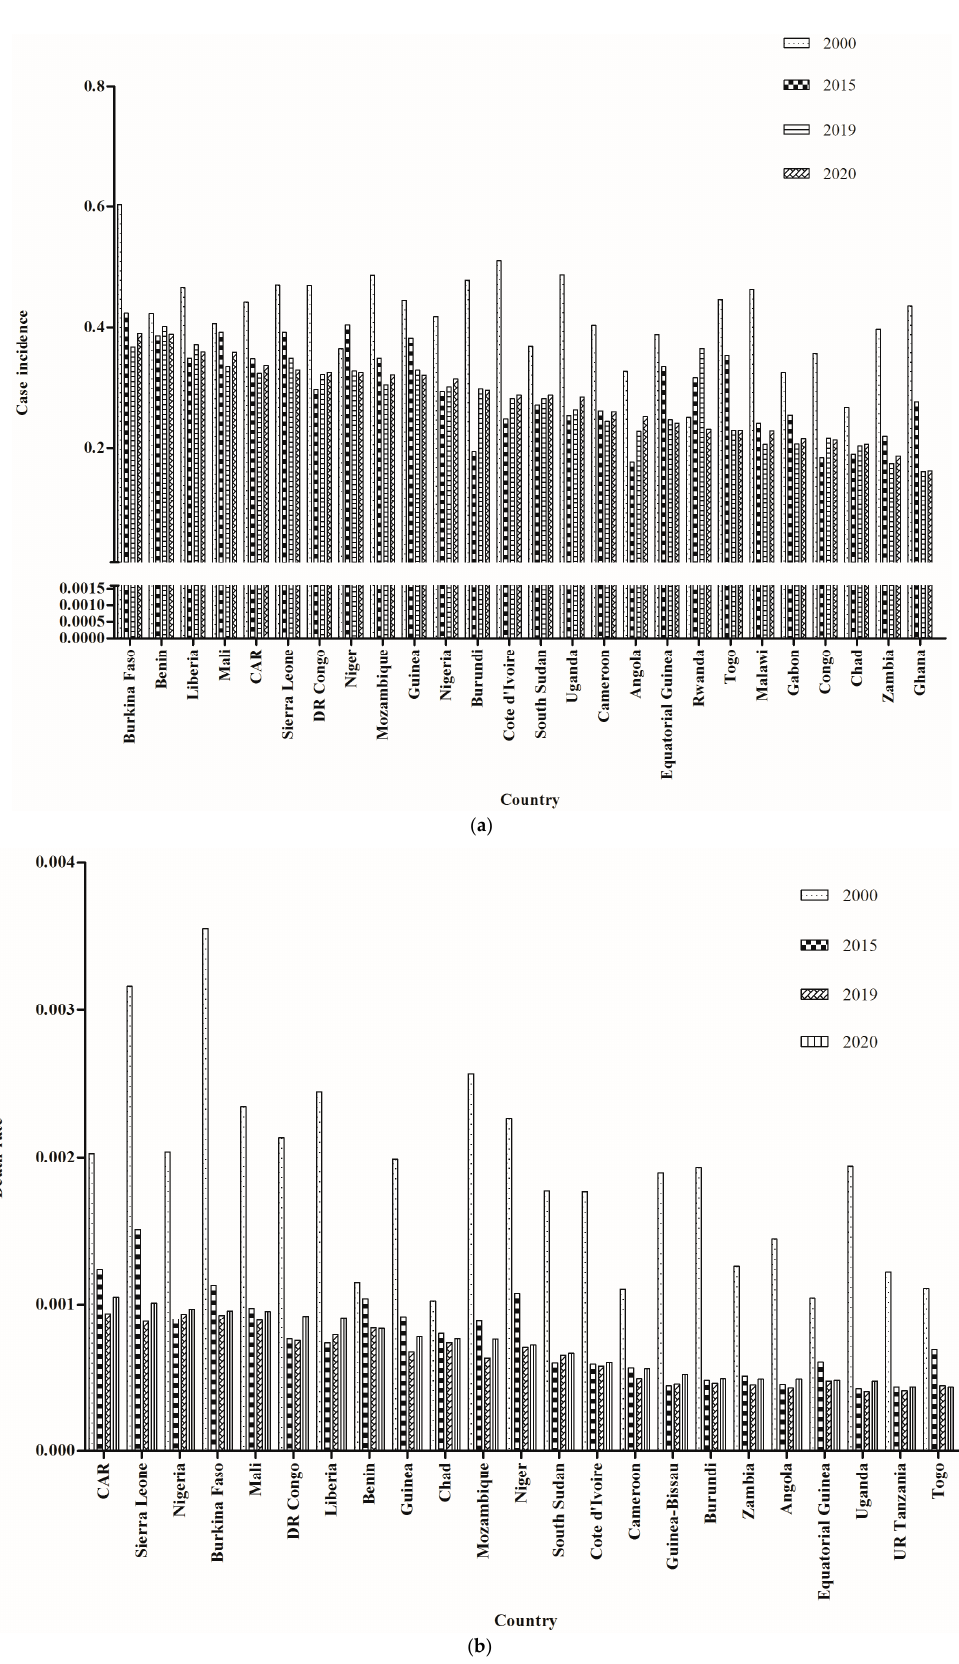
Figure 5. Comparison of the incidence rate ( a ) and death rate ( b ) resulting from malaria in African countries across 4 years. 3.5. COVID-19 Pandemic Disruption to Health Services and Malaria Control in Africa The restriction of movement, intermittent health services, reduced visits to health fa- cilities due to fear of getting infected with and being diagnosed with COVID-19, and the stigmatization of COVID-19 treatment centers have culminated in the ineffective treat- ment of malaria. Our preliminary analysis showed that the COVID-19 pandemic impacted the health service and malaria control in Africa in multiple ways and in various aspects. The main impacts are the following: investment budget decreases, medical resources shortages, the disruption or delay of pillar control measures, reduced access to healthcare services, reduced and delayed diagnostic and clinical visits, and restrictions on and dis- ruption to the availability of curative and preventive malaria commodities as well as the mental burden. Moreover, vaccine hesitancy (VH) and stigmatization due to COVID-19 vaccines could further affect the introduction and use of the malaria vaccine in Africa. 3.6. Gap in Financial Investment in Malaria Control There was a significant gap in financing malaria control globally, and this imposed a significant burden on the economies of AFR countries. Despite the total investment fund- ing for malaria control and elimination being successively increased from 2018 to 2020, constituting USD 2.7 billion in 2018 [18], USD 3.0 billion in 2019 [2], and USD 3.3 billion